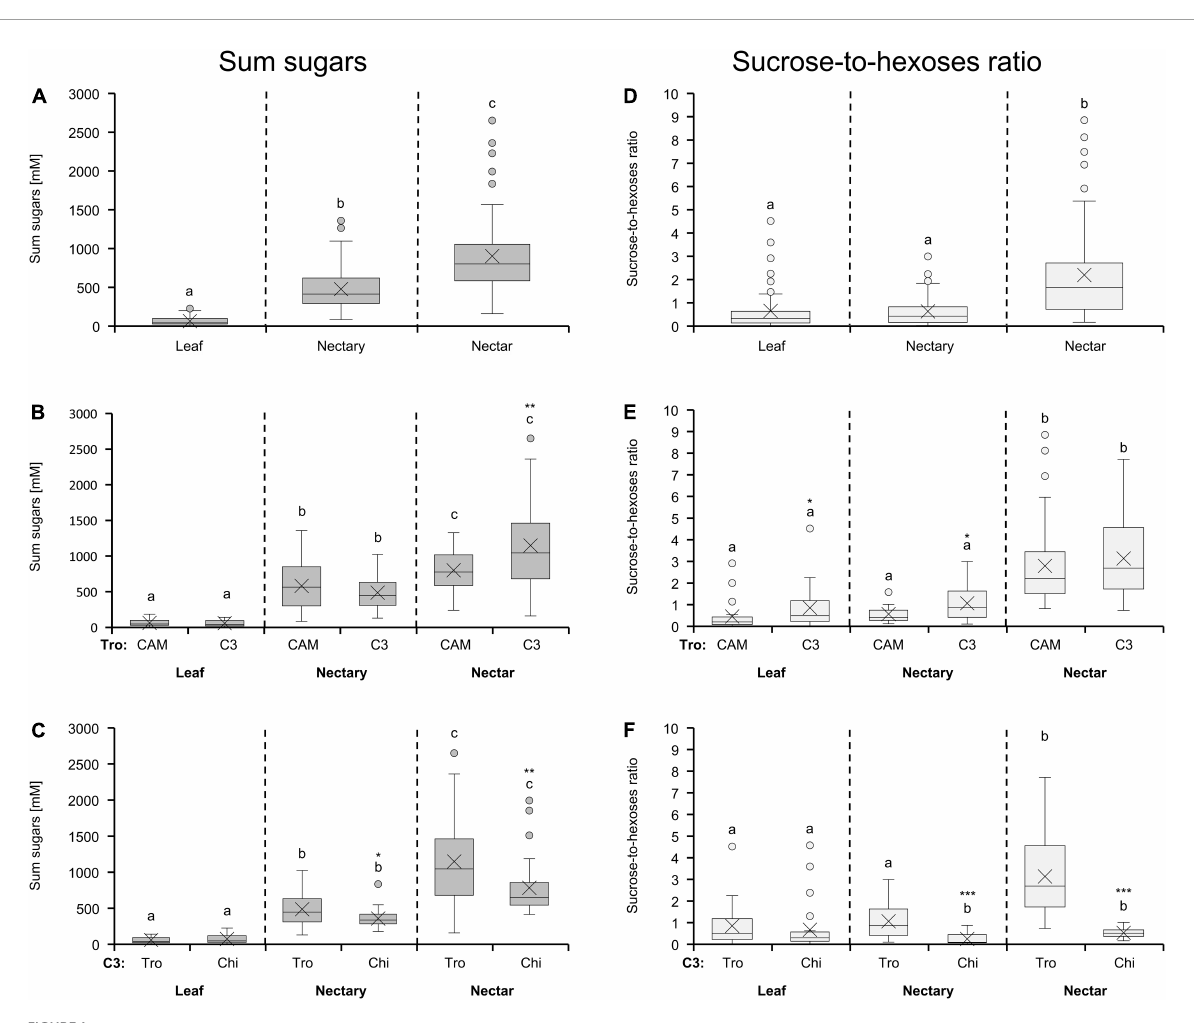
FIGURE1 Sum of sugars (glucose, fructose and sucrose) and sucrose-to-hexoses ratios in leaf, nectary and nectar (A,D) . The shown data includes all 36 bromeliad species ( n = 3). Additionally, the data were separated by photosynthesis type (B,E) and pollinator type (C,F) in the boxplot diagrams. The separation according to photosynthesis type includes 14 species with CAM photosynthesis and 22 species with C3 photosynthesis. All CAM species have trochilophilous pollinators whereas the C3 species have either trochilophilous (tro) or chiropterophilous (chi) pollinators. Therefore, the C3 species were separated according to the pollinator type in 11 trochilophilous (tro) and 11 chiropterophilous (chi) species. Different letters represent significant differences in sum of sugars or sucrose-to-hexoses ratios, respectively, between leaf, nectary and nectar (Tukey’s HSD; p < 0.05). The asterisks show different levels of significance between the photosynthesis or pollinator types, respectively (* p < 0.05, ** p < 0.01, *** p <